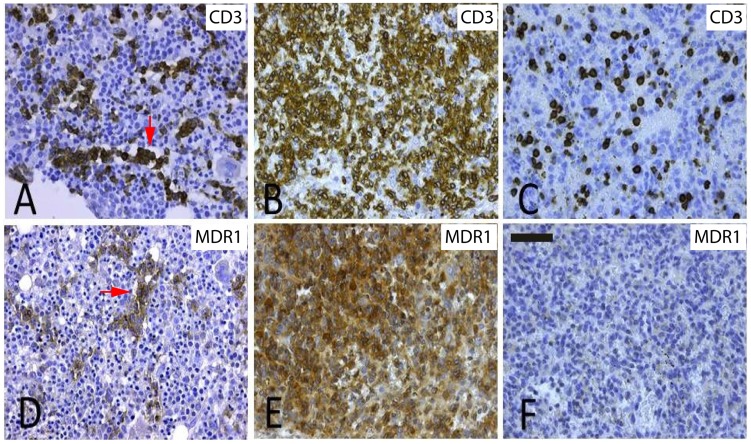
Morphology and ABCB1 expression in HSTL cases detected by IHC.Immunohistochemical stainings (A–C, anti-CD3; D-F, anti-MDR1/ABCB1) of the typical intrasinusoidal spread (red arrows) by HSTL cells in the bone marrow (A/D, case 4) and spleen (B/E, case 6), respectively, compared to staining pattern in normal spleen (C/F). Pictures captured by Leica DFC290HD camera at 400X. Scale bar  = 50 µm.